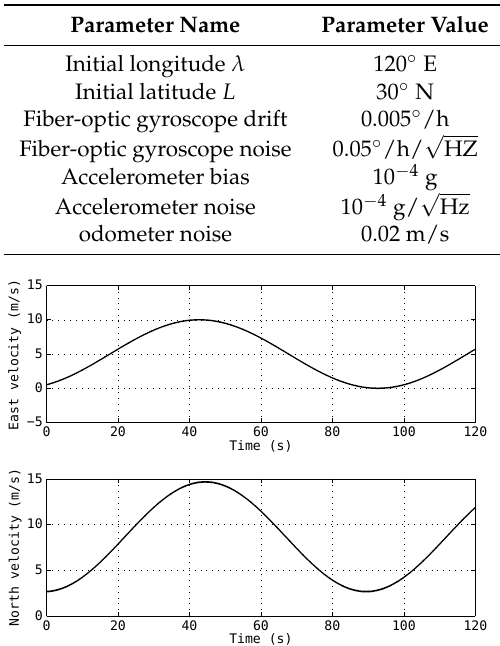
Table 1. Initial parameters.